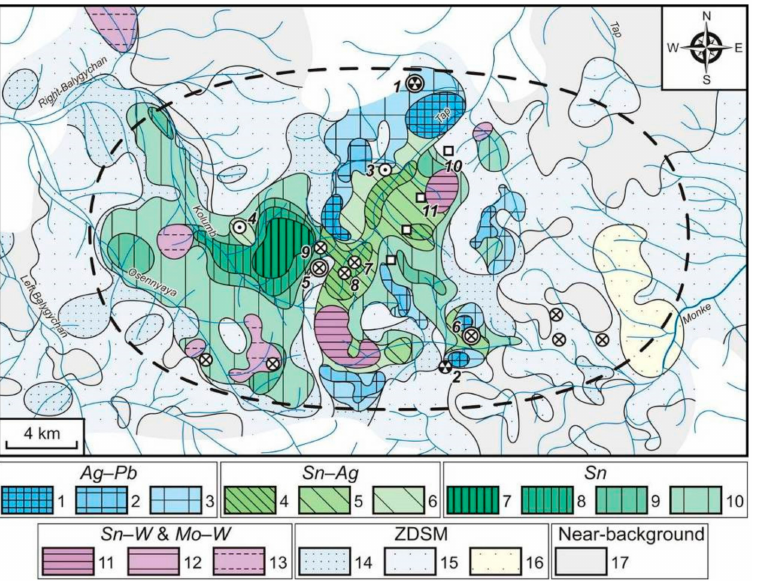
Figure 6. The Pestrinsk SBS. Polyelement AGCFs identified through SSs (survey at 1:200,000 scale). 1–17—geochemical associations of elements (see Table 2): 1–3— Ag – Pb ; 4–6— Sn – Ag ; 7–10— Sn ; 11– 13— Sn – W , and Mo – W ; 14–16—variable composition in disseminated sulfide mineralization (ZDSM); and 17—near-background (contrast ratio (CR) average values for all elements less than